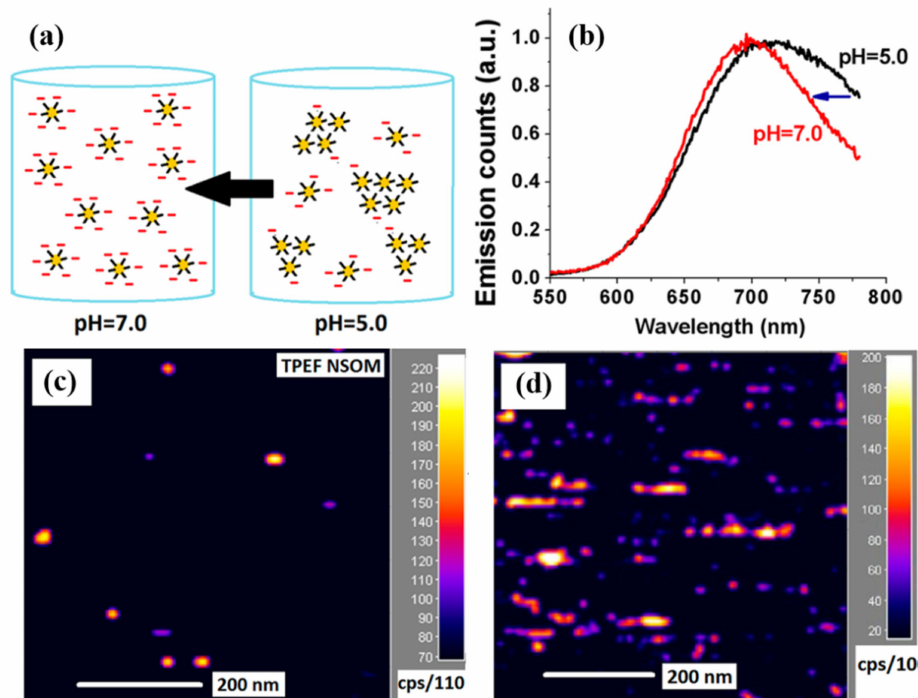
Figure 13. ( a ) Changes in pH lead to changes in the spacing of Au 25 nanoclusters. ( b ) The increase in pH narrows the change in the full width at half the maximum of the emission peak of the molecule. ( c , d ) are the TPEF imaging results of 1.4 nm and 12 nm solutions coated on the glass substrate surface, respectively [58]. Republished with permission from Ref. [58]. Copyright 2022 American Chemical